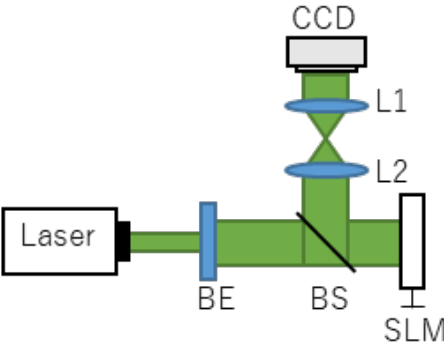
Figure 8. Schematic of the experimental system used for holographic recording. SLM: reflective liquid crystal spatial light modulator with pixel size of 12.5 µ m and resolution of 1280 × 1024; Laser: He-NE laser with a wavelength of 633 nm; BS: beam splitter; BE: beam expander; L1 and L2: lens with a focal length of 50 mm; CCD = charge-coupled device camera.